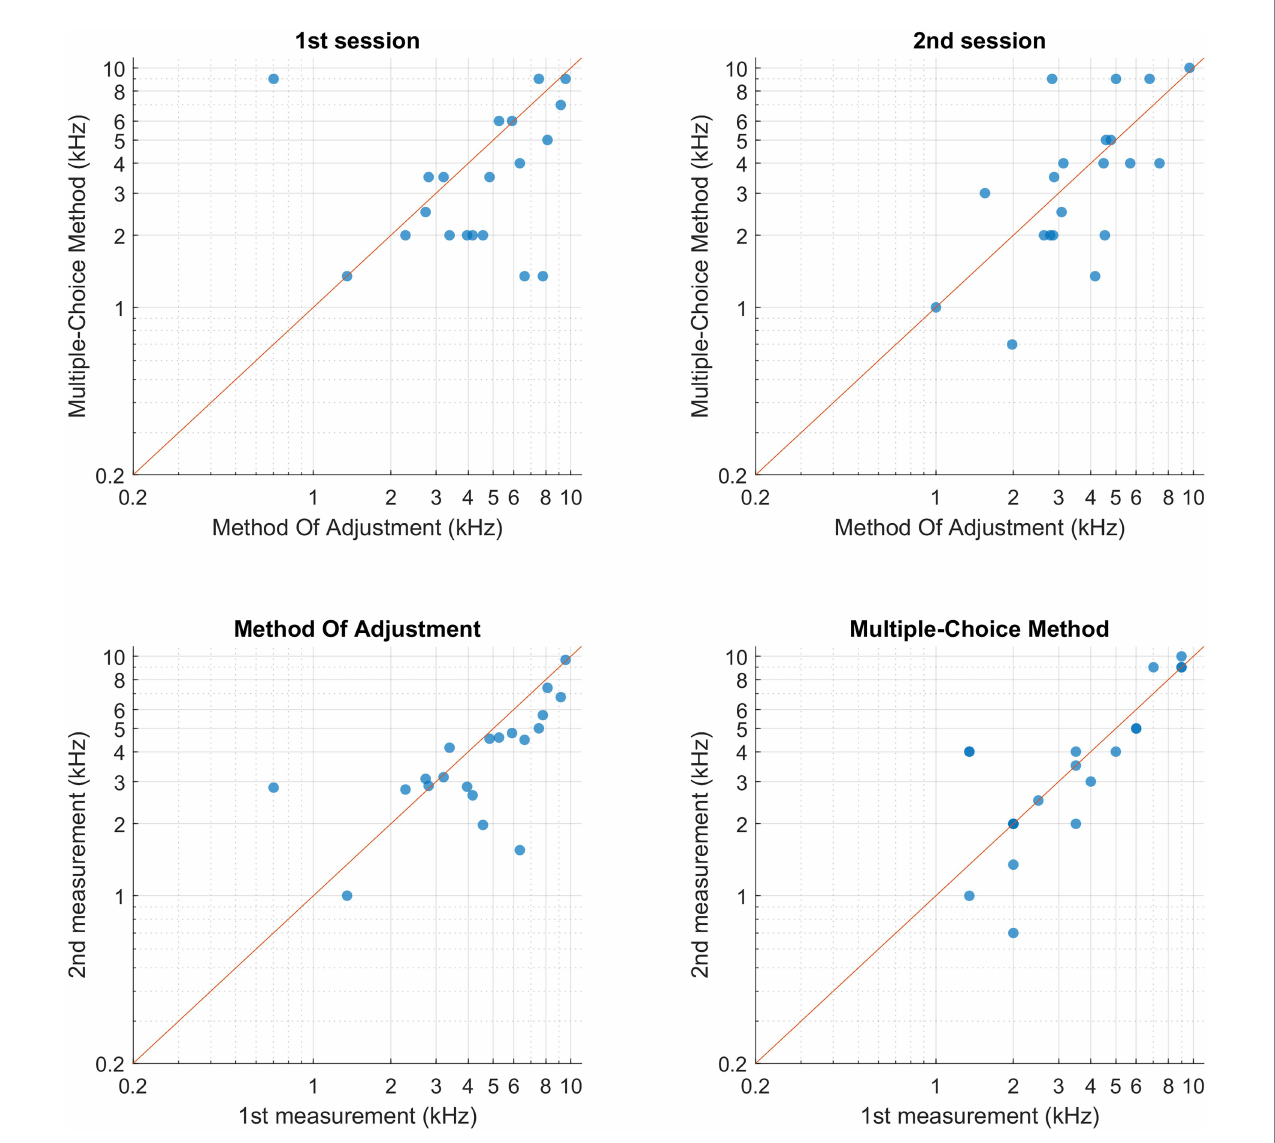
FIGURE 4 Participant’s pitch-matching results for both methods and both sessions, each data point represents one participant. (Upper-left corner) Comparison between bothmethods within the 1st session. (Upper-right corner) Comparison between both methods within the second session. (Bottom-left corner) Comparison within MOA between both sessions.(Upper-right corner) Comparison within MCM between both